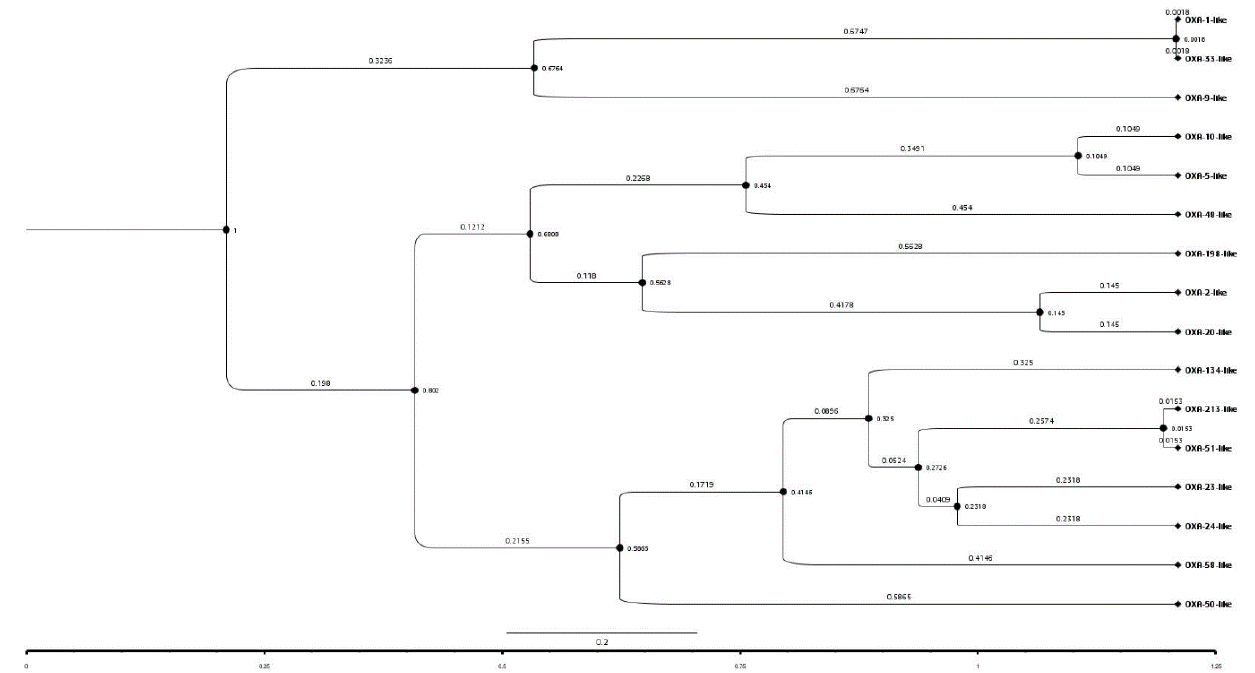
Figure 3. A time-stamped phylogenetic tree of a representative sequence from sequences of the 16 OXA subfamilies. The tree session is also shared for a broader view (https://raw.githubusercontent.com/University-of-Delhi-south-campus/OXA-beta-lactamase/main/Tree%20session.svg, accessed on 15 September 2021).